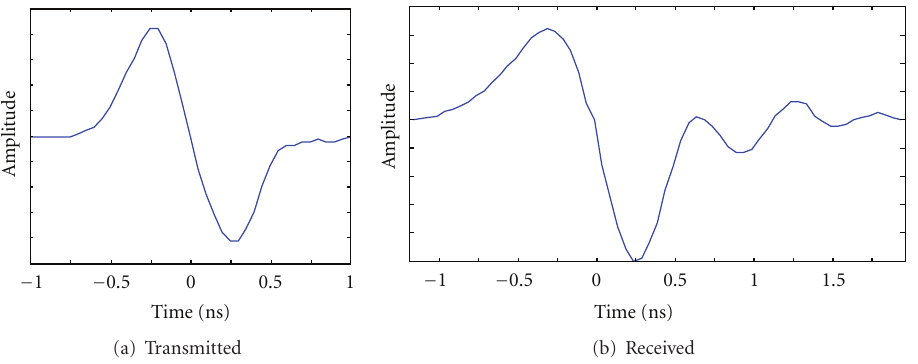
Figure 3: Baseband monopulse waveforms.